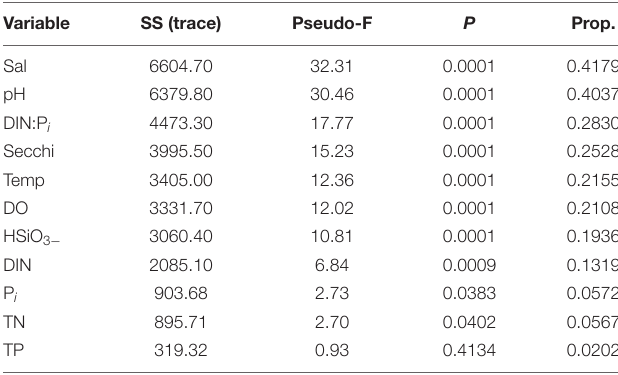
TABLE 3 | Results of the DISTLM analysis that was run on biological data matrix with the environmental data as the predictor variables.